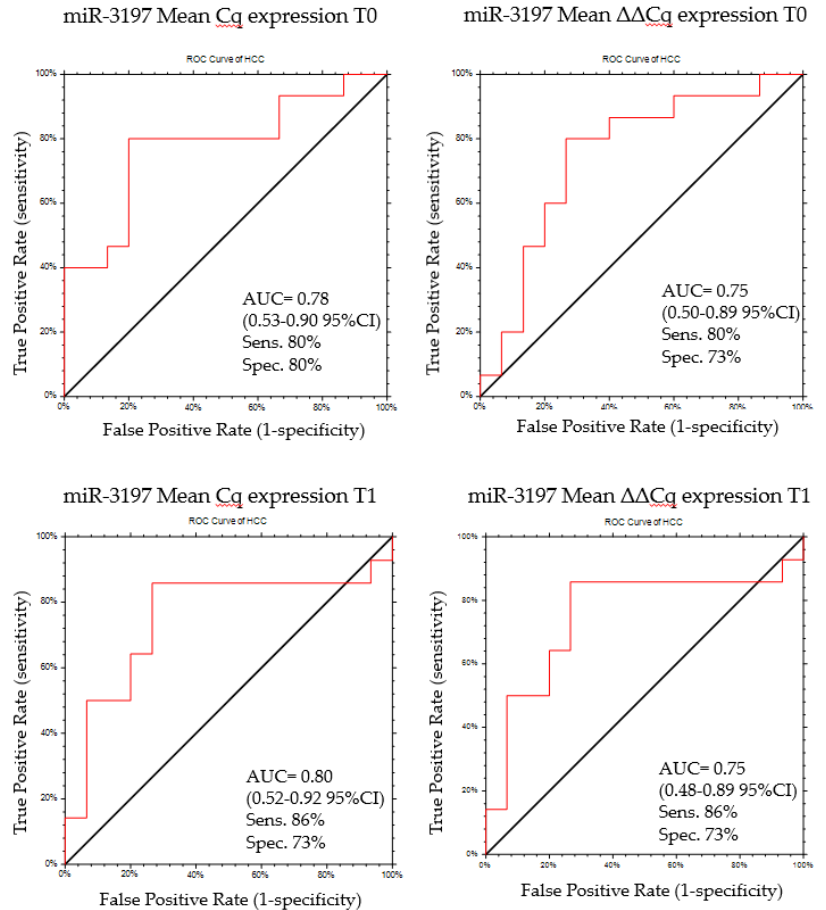
Figure 4. ROC curve for miR-3197 discriminatory potential between patient HCC+ and HCC− at T0 and T1 using both normalized and non-normalized data.